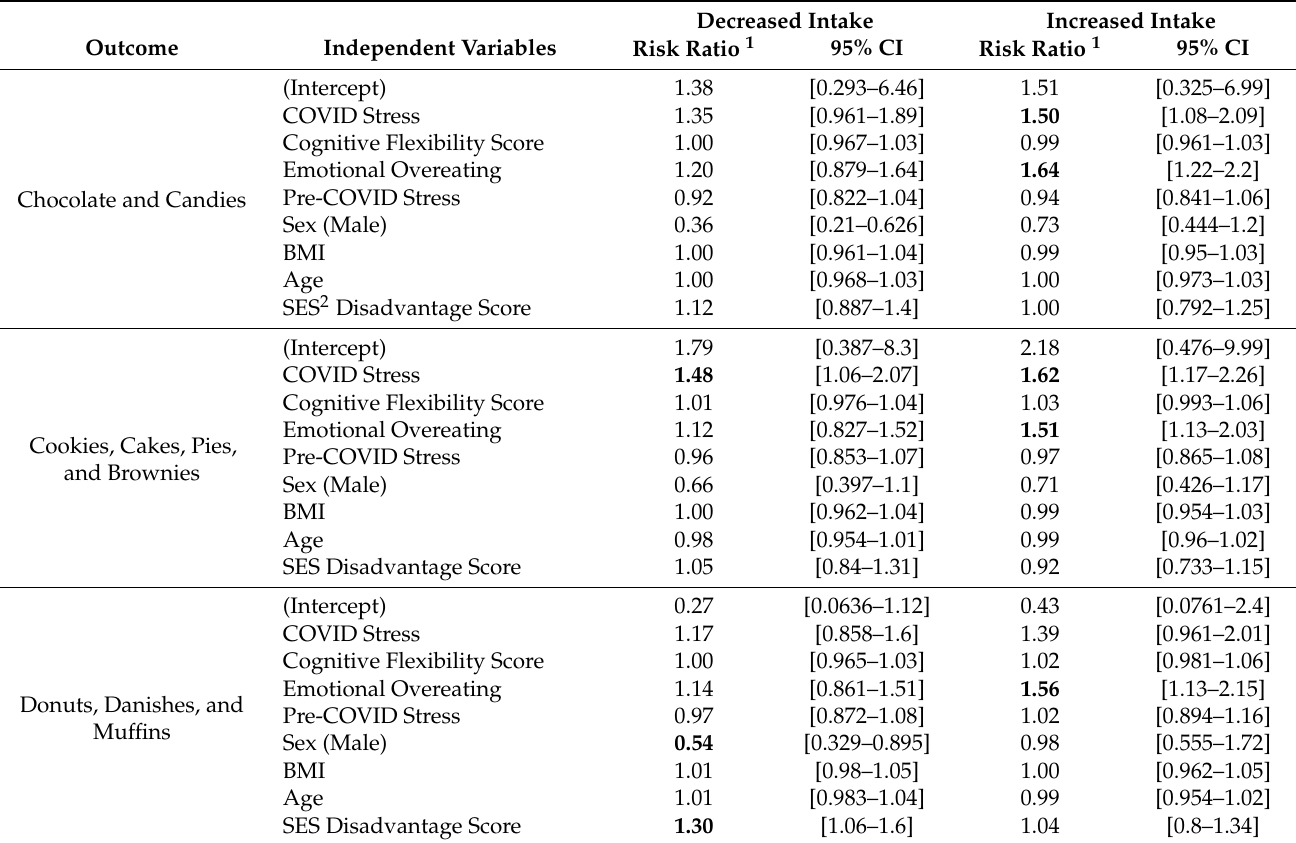
Table A2. Full multinomial logistic regression models with covariates ( n =